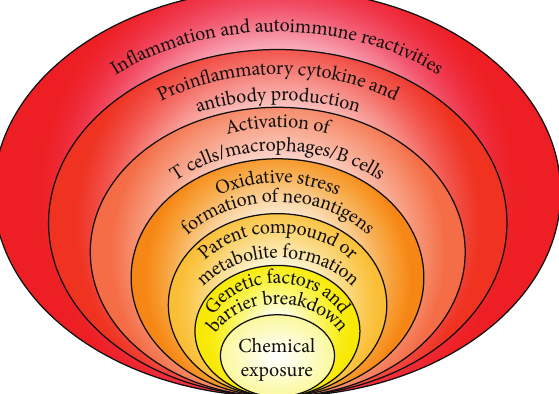
Figure 4: Potential molecular mechanisms implicated in chemical-induced autoimmune